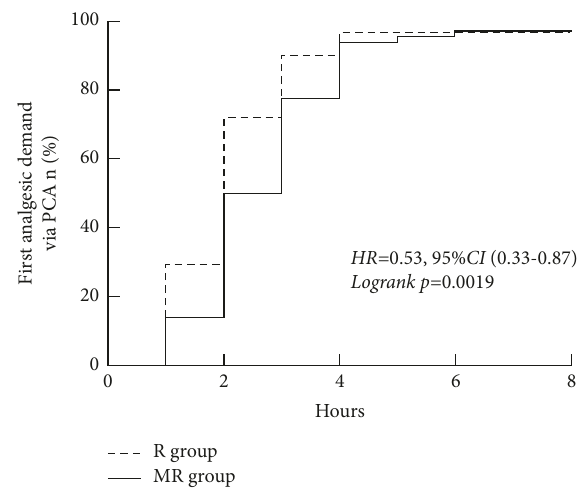
Figure 2: Comparison of estimated median time of analgesic demand via PCA between the MR (methylprednisolone plus ropivacaine) group and the R (ropivacaine) group. Table 3: Comparison of postoperative nausea and vomiting (PONV) along with Ramsay Sedation Score (RSS) between the MR (methylprednisolone plus ropivacaine) group and the R (ropiva- caine) group within the 48-hour postoperative